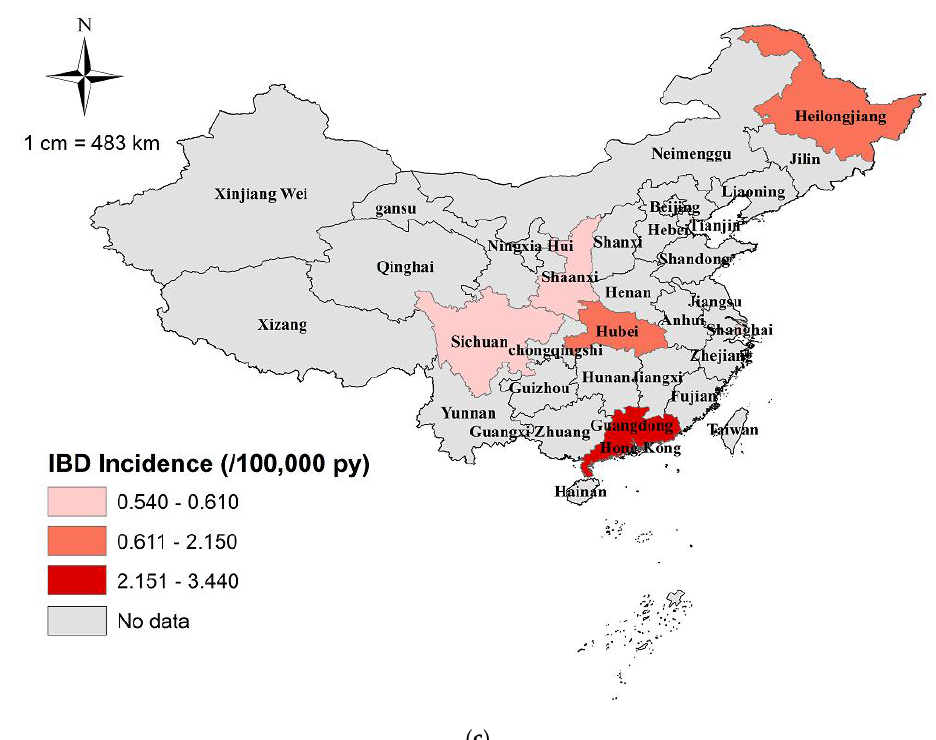
Figure 3. National map of the incidence rate of inflammatory bowel disease: ( a ) Crohn’s disease (CD); ( b ) ulcerative colitis (UC); ( c ) inflammatory bowel disease (CD and UC).